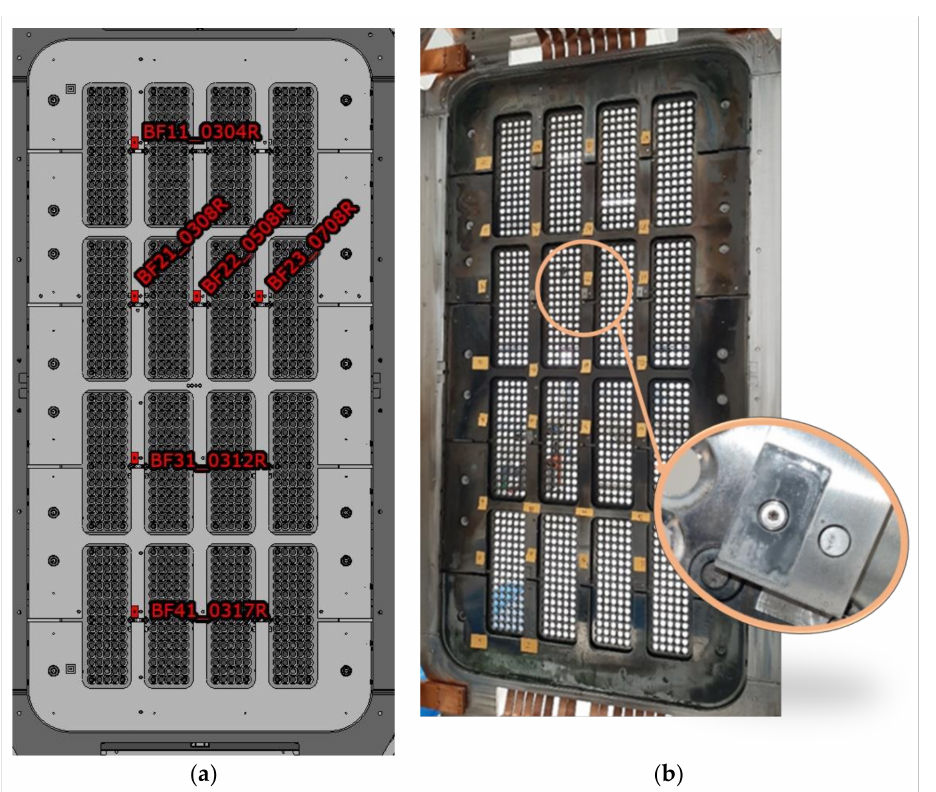
Figure 3. ( a ) BF Probes name and ( b ) position on